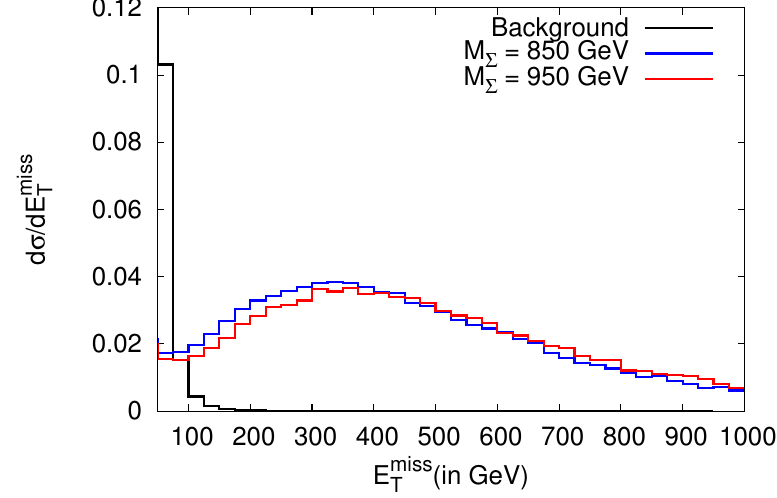
Figure 6 . =E distribution of the single heavy stable charged tracks of (cid:17) (cid:6) T points BP1 (blue) and BP2 (red) as in table 2. Background =E for BP1 (BP2) with an integrated luminosity 343 (1080) fb (cid:0) 1 . The di(cid:11)erence is small because the SM background at LHC is